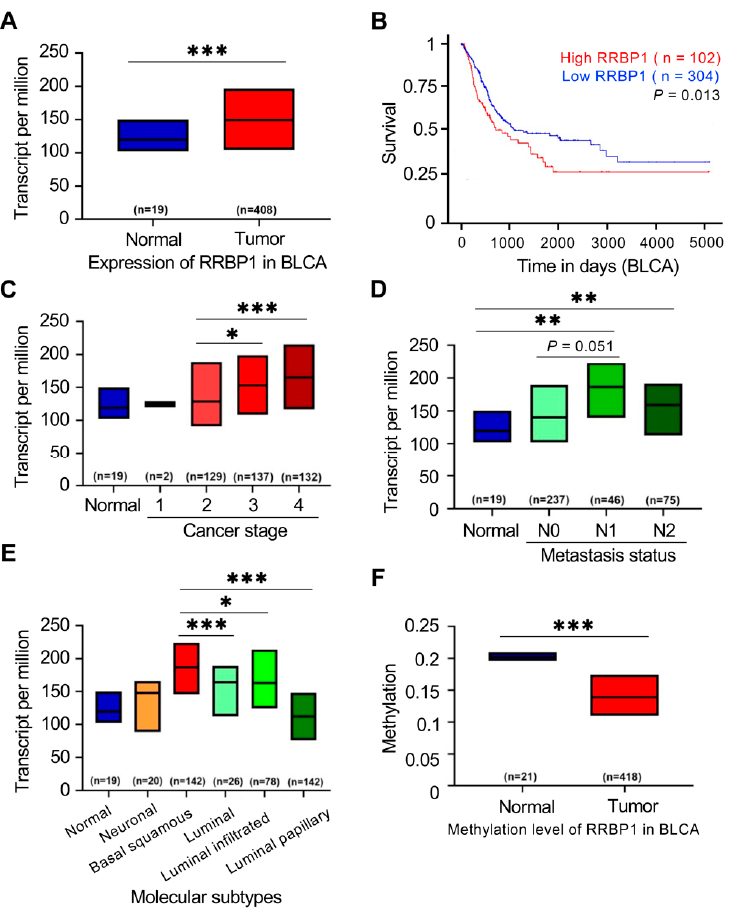
Figure 2. RRBP1 is hypomethylated in BLCA and is correlated with tumor malignancy. ( A ) High expression of RRBP1 transcripts in BLCA tumors. ( B ) High expression of RRBP1 is associated with lower survival rate of BLCA patients (log-rank test, p = 0.013). ( C ) High expression of RRBP1 in individual cancer stages of BLCA. ( D ) High expression of RRBP1 in metastatic nodal. ( E ) High expression of RRBP in basal squamous and luminal-infiltrated subtypes. ( F ) Low level of methylation in RRBP1 promoter. (* p < 0.05; ** p < 0.01; *** p < 0.001.) Student t -test with two-tailed p